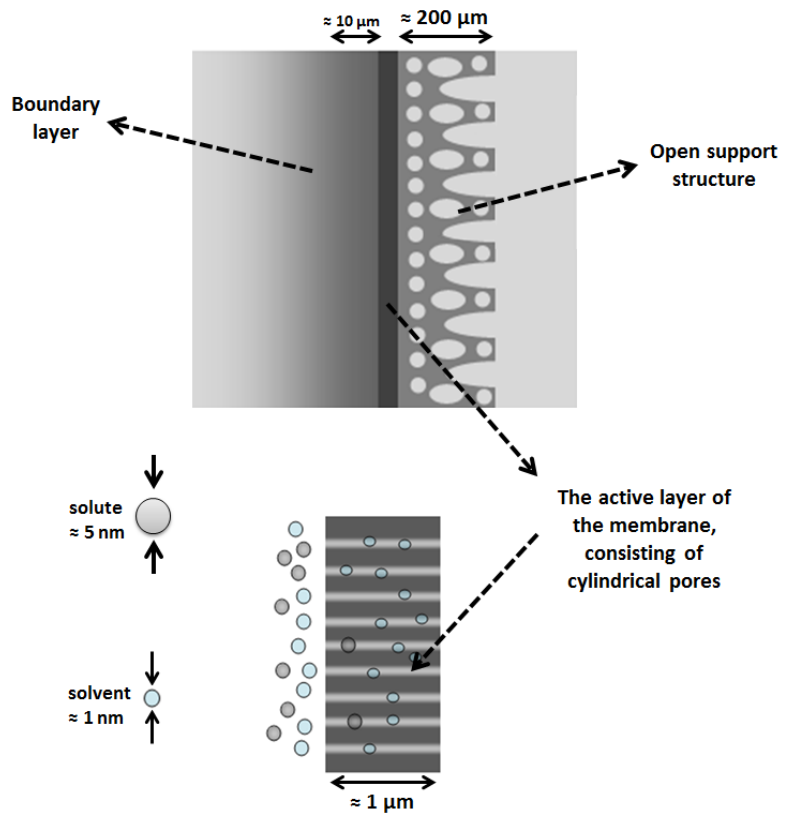
Figure 1. Schematic representation of SRNF membrane, dimension of parameters and membrane.